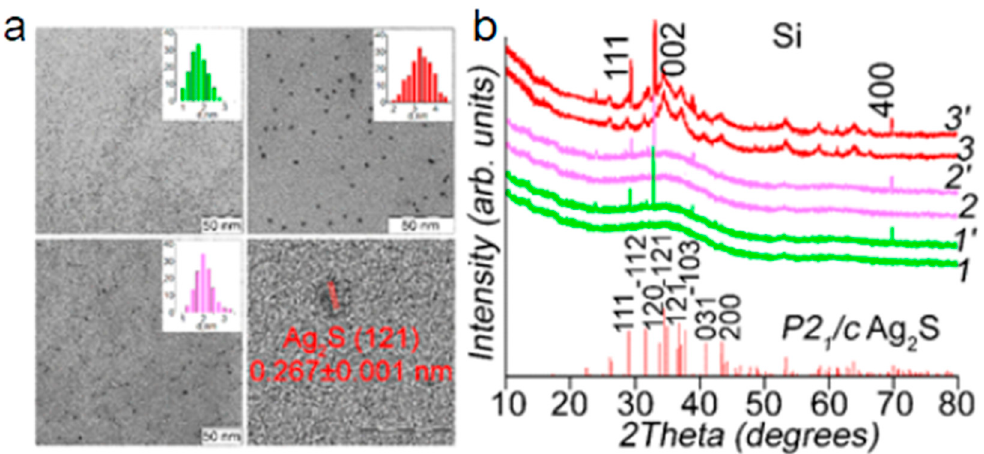
Figure 1. Transmission electron microscopy (TEM) images with size histograms of Ag 2 S quantum dots (QDs) deposited on an Si substrate ( a ); X-ray diffraction (XRD) patterns of Ag 2 S QDs with different sizes (1–3), curves with dashed numbers (1’–3’) respect to Ag 2 S QDs deposed on Si substrate ( b ).